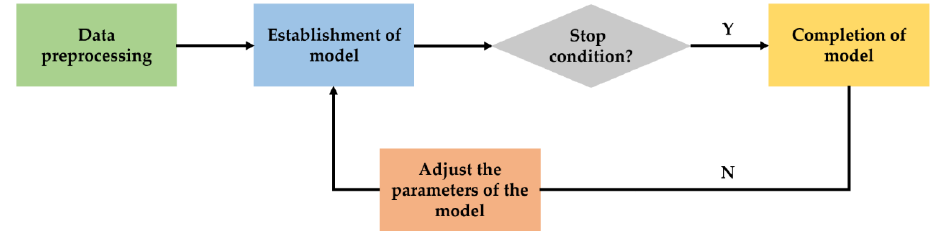
Figure 6. Flow chart of RF modeling.